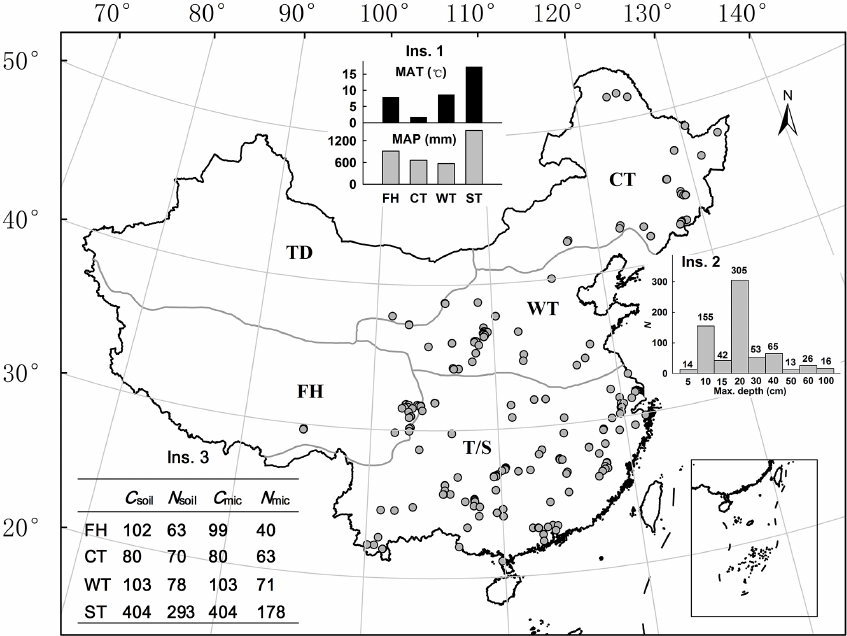
Figure 1. A map of China showing the distribution of sampling sites and data summary for this synthesis. The climate zones are categorized following Wu (1988) into frigid highland (FH), cool temperate (CT), warm temperate (WT), subtropical/tropical (ST), and temperate desert (TD) zones. The TD is excluded in the synthesis, because forests are rarely distributed in the zone. Inset 1: mean annual temperature (MAT) and mean annual precipitation (MAP) by climate zones. Inset 2: frequency distribution of maximum depth of soil sampling. Inset 3: the number of measurements of soil organic carbon (C soil ) , soil total nitrogen (N soil ) , microbial biomass carbon (C mic ) , and microbial biomass nitrogen (N mic ) by climate